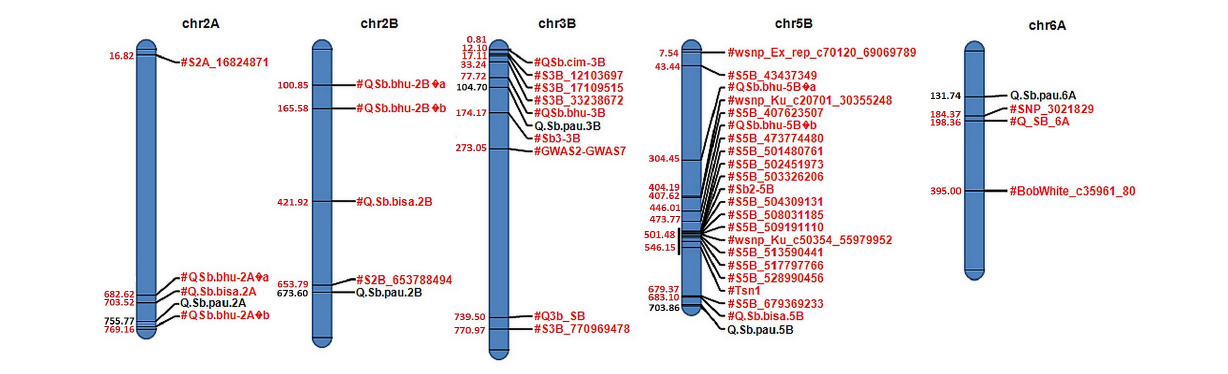
to 5.02. QTL QSb.pau-2A was mapped at chromosome 2A